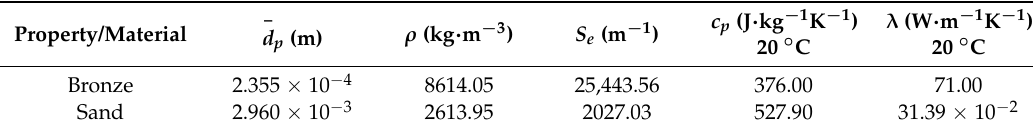
Table 1. Physical properties of the solid phase.